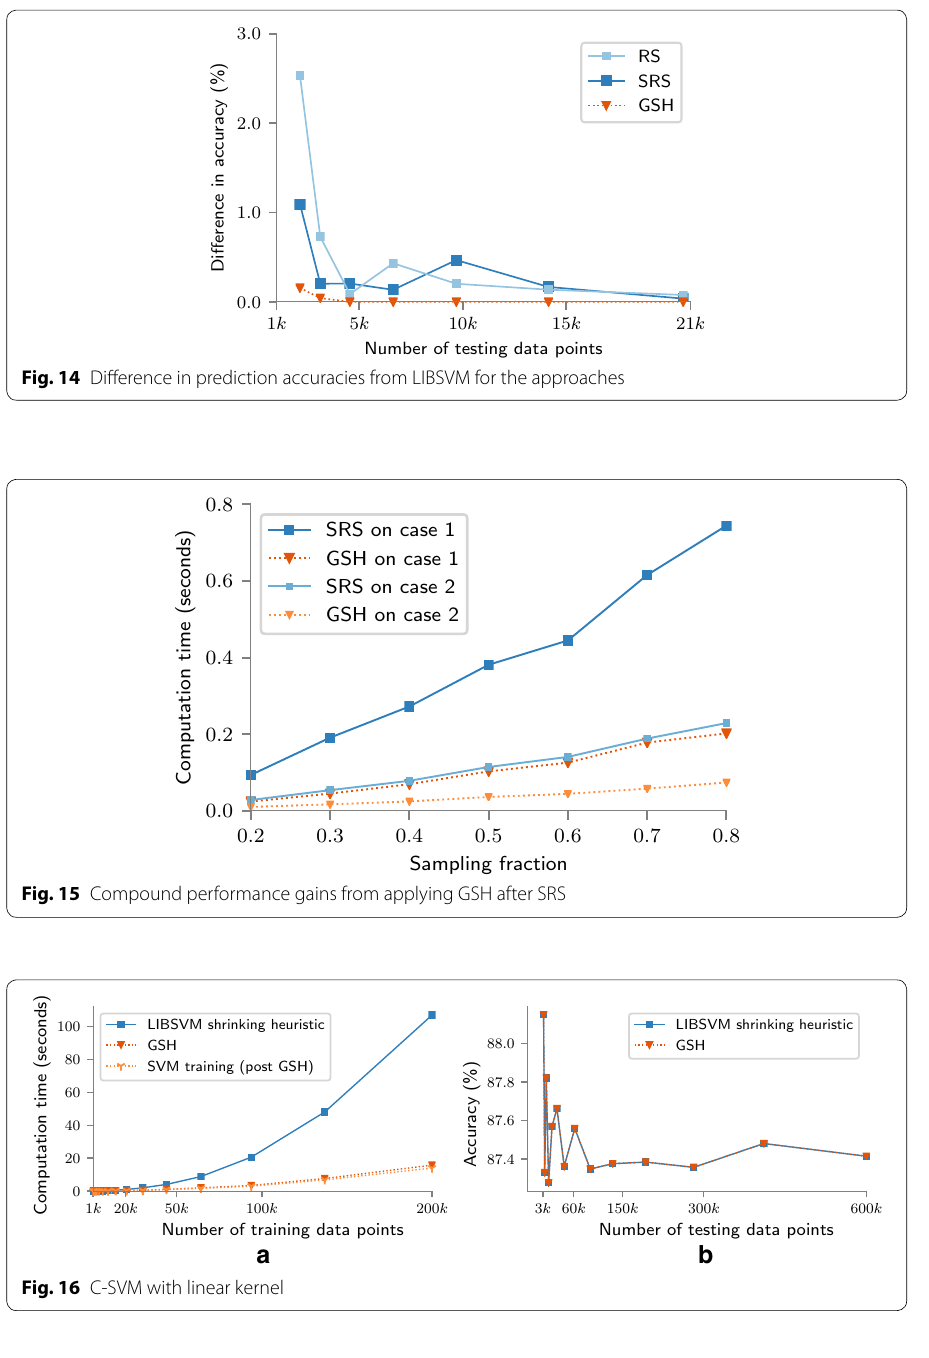
‘GSH’ plots include the run-time of Step 1 to 3 of the heuristic along with the training phase. A third line-plot denoted ‘SVM training (post GSH)’ is presented in Subfigure (a) to separate computation run-time of GSH from subsequent training.